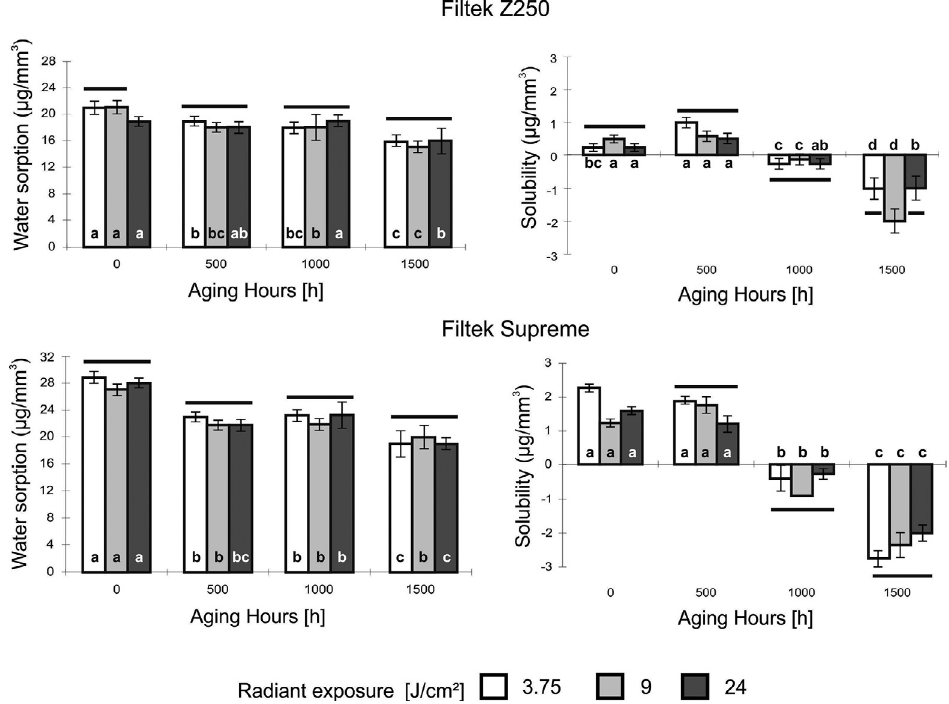
Figure 5- Water sorption and solubility for Filtek Z250 (top) and Filtek Supreme (bottom) at different radiant exposures and UV accelerated aging hours. Columns under the same horizontal line indicate no differences between radiant exposure for each period of aging hours. Different lowercase letters indicate differences between aging hours within each radiant